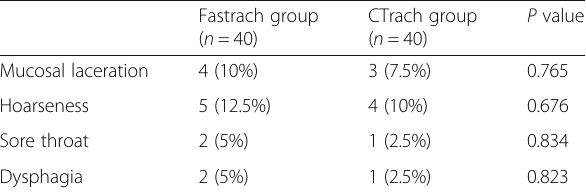
Table 5 Postoperative complications, data are number (%)